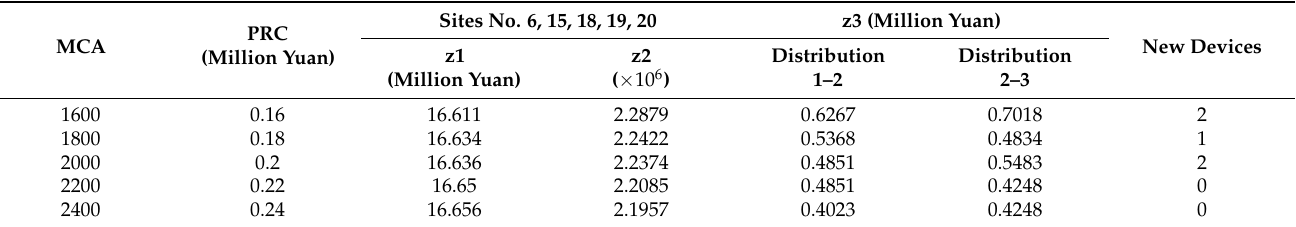
Table 10. Sensitivity analysis for MCA and PRC.